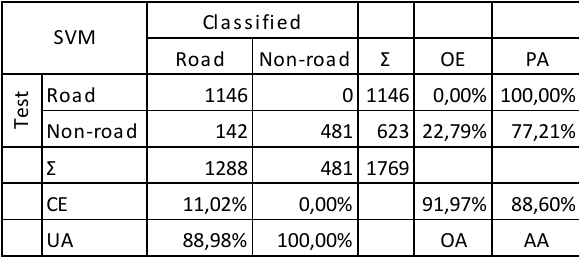
Table 1. In-sample accuracy for SVM classifier